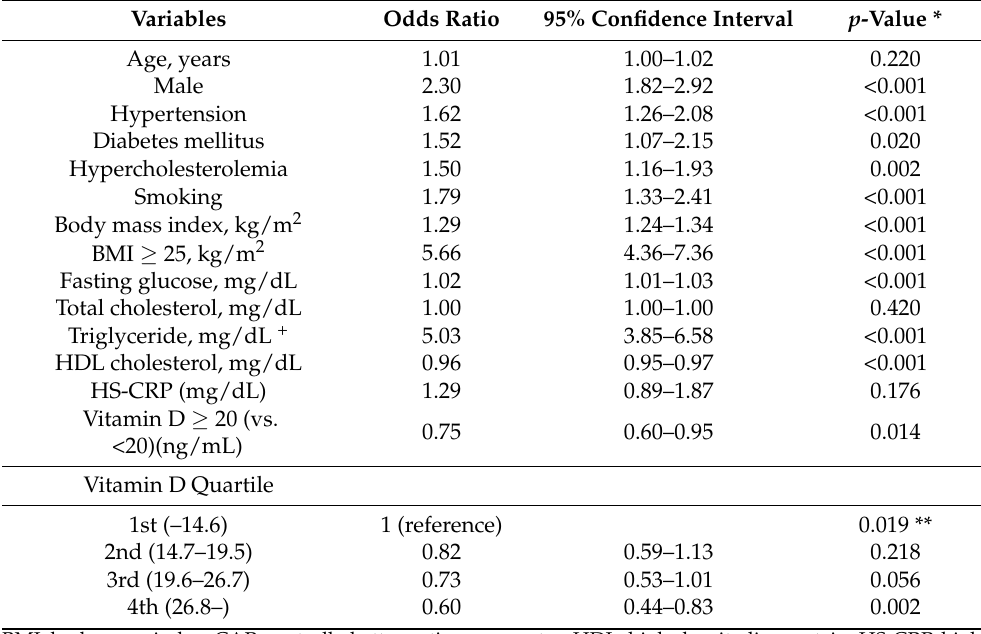
Table 2. Parameters associated with NAFLD (CAP ≥ 248 dB/m).